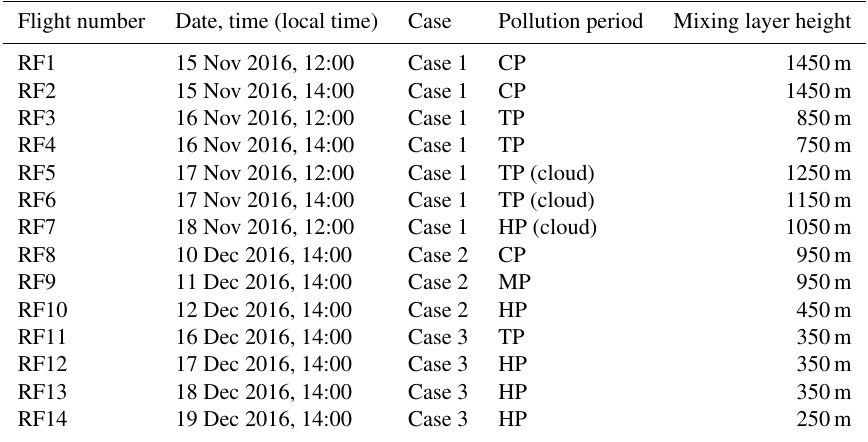
Table 1. Flight summary in this study. Flight number Date, time (local time) Case Pollution period Mixing layer height RF1 15 Nov 2016, 12:00 Case 1 CP 1450m RF2 15 Nov 2016, 14:00 Case 1 CP 1450m RF3 16 Nov 2016, 12:00 Case 1 850m 750m 1250m 1150m Case 1 1050m